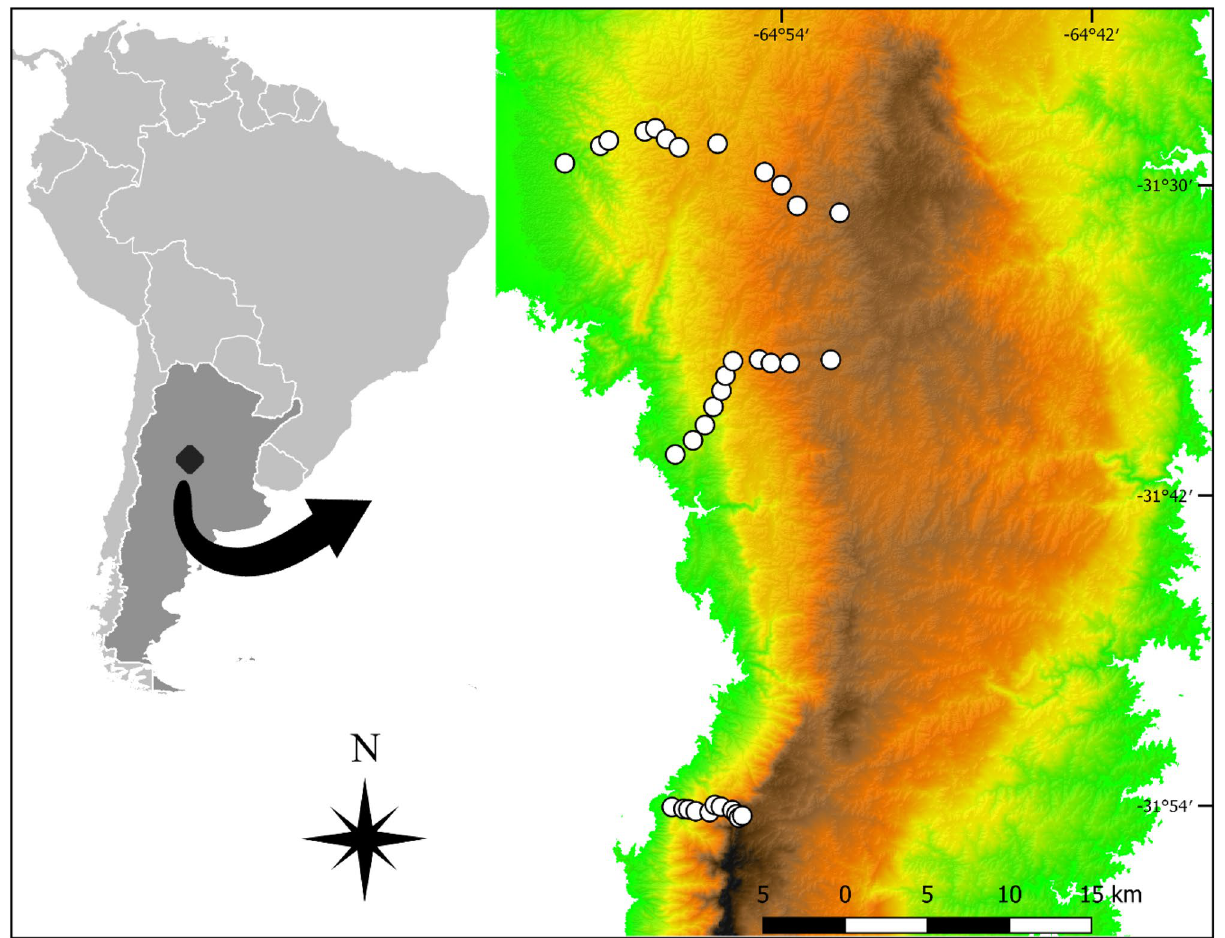
Figure 5. Location of the study sites in Sierras Grandes Mountains in central Argentina. Map created using the Free and Open Source QGIS 50